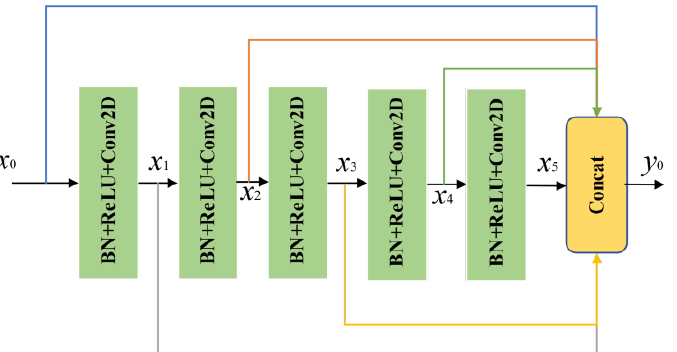
Figure 3. The one-shot aggregation module, where x 0 , x 1 , x 2 , x 3 , x 4 , and x 5 denote the input of each layer of the convolution layer; y 0 denotes the output; and concat denotes the feature concatenation operation. Rectified linear unit (ReLU) denotes an activation function. Batch normalization (BN) denotes centering and scaling activations within mini-batches. Conv2d denotes a 2D convolutional layer.